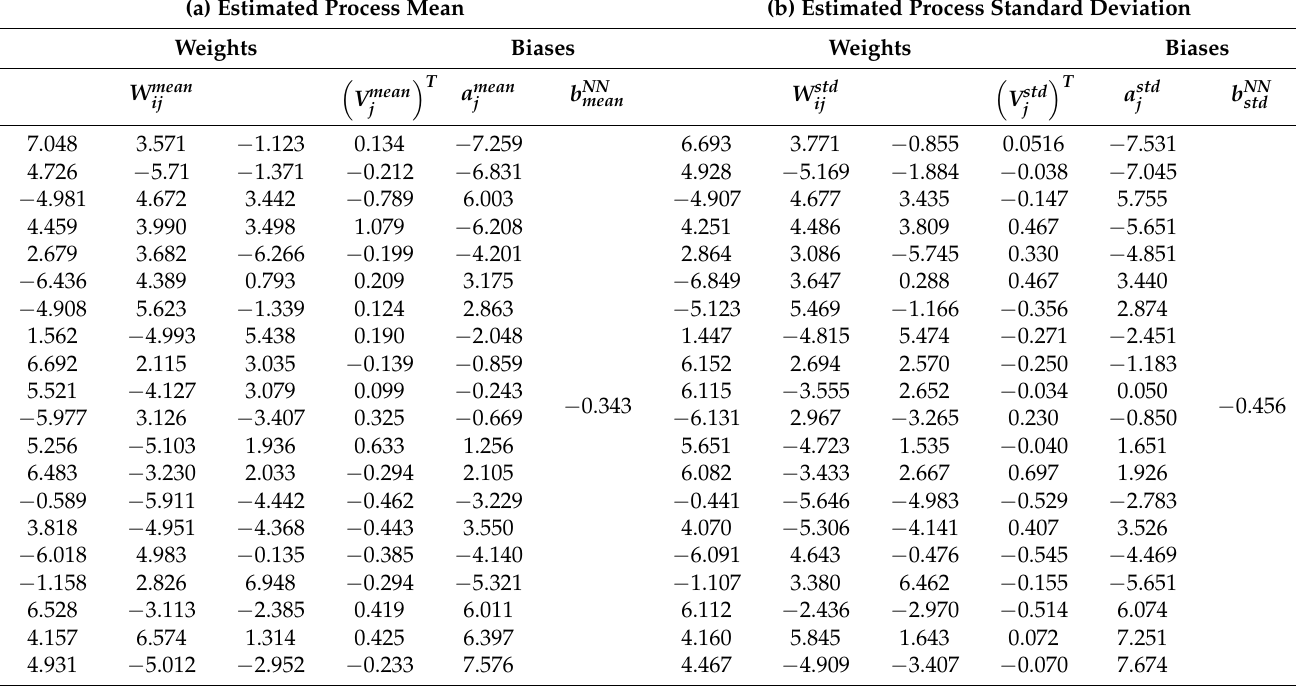
Table 2. Weight and bias values from the NNs approach by using the conventional log-sigmoid transfer function.